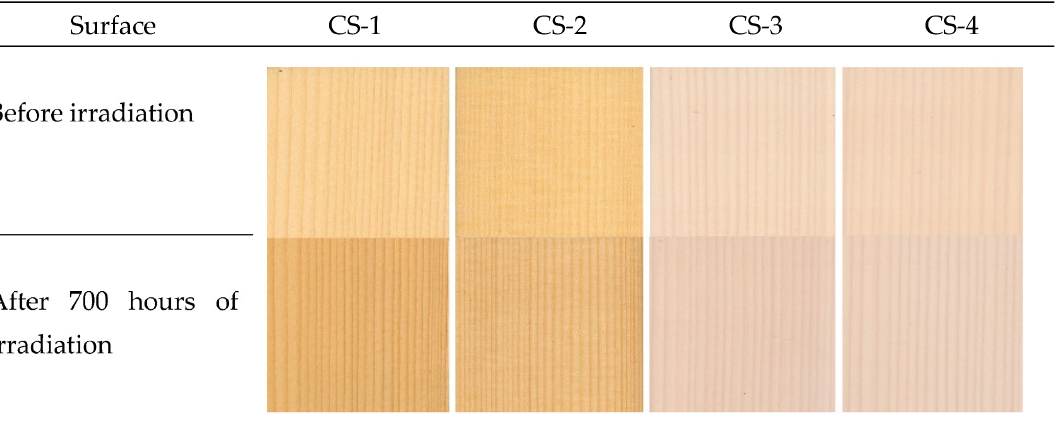
Figure 8. Colour of spruce wood surfaces coated with specific water-based coating systems before and after irradiation in the accelerated aging process.